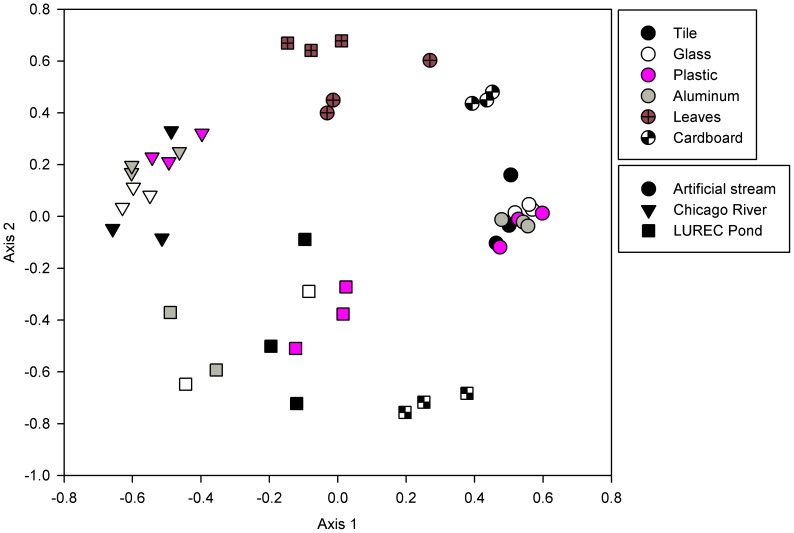
Non-metric multidimensional scaling (nMDS) ordination of bacterial communities based on high-throughput sequencing of bacterial 16S rRNA genes from biofilms colonizing anthropogenic litter (AL) substrates (glass, plastic, aluminum, and cardboard) and natural surfaces (leaves and tile) in artificial streams at Loyola University Chicago, the North Branch of the Chicago River, and a pond at Loyola University Retreat and Ecology Campus (LUREC).